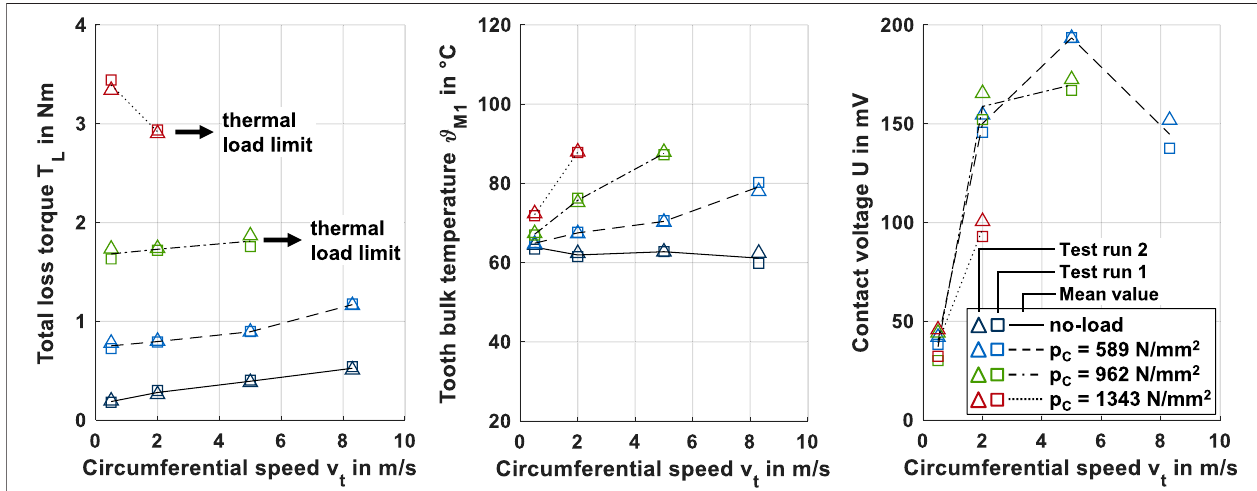
FIGURE12| MeasuredtotallosstorquesT V ,bulktemperatures ϑ M1 andcontactvoltagesUovercircumferentialspeedv t forno-loadanddifferentloadsunderDoD lubrication at the gear test rig.